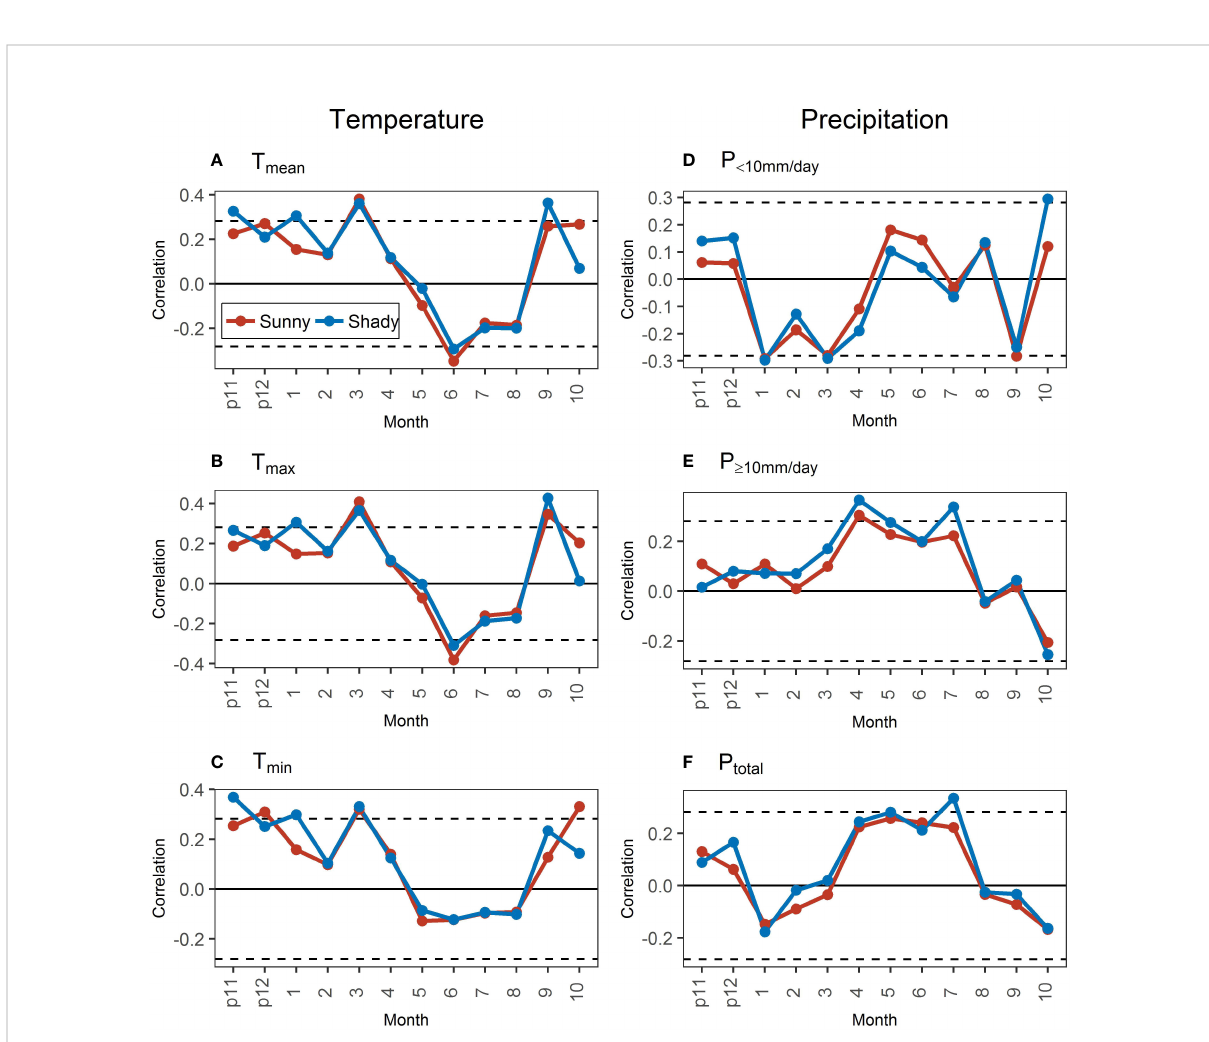
FIGURE 8 Correlations of standard chronologies (STDs) with monthly temperature (A – C) and precipitation (D – F) variables in the sunny and shady slopes during 1971 – 2020. The dotted black lines represent the signi fi cance level at 0.05. “ p11 ” and “ p12 ” represent November and December of the previous